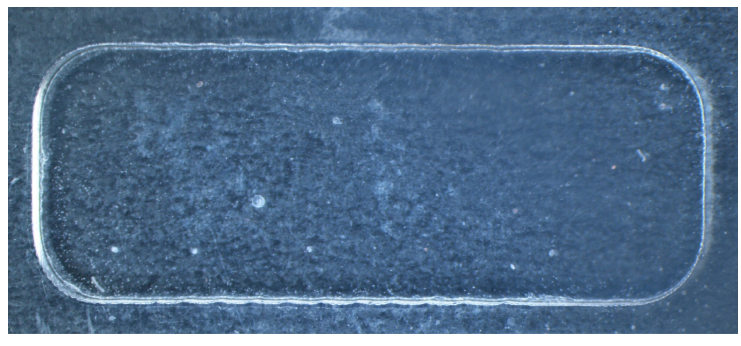
Figure 9. The effect of the cyclohexane vapor post-treatment on the optical transparency of milled COC. ( a ) shows a milled surface and ( b ) the same surface, but post-treated with cyclohexane vapor. The graph in Figure 10 shows the transmittance data of these